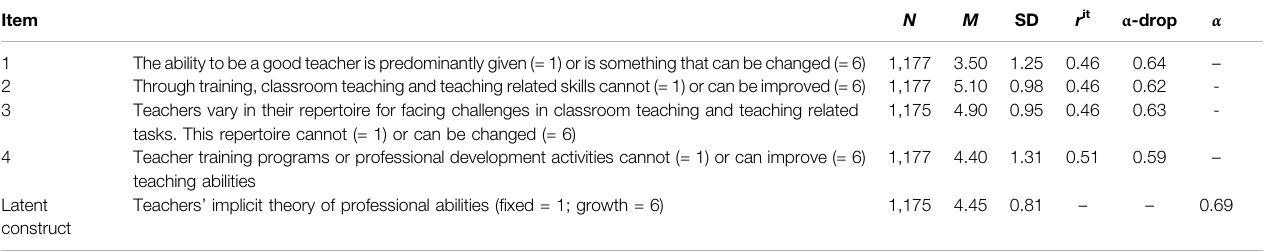
TABLE 2 | Measurement instrument to assess teachers ’ implicit theories of professional abilities.